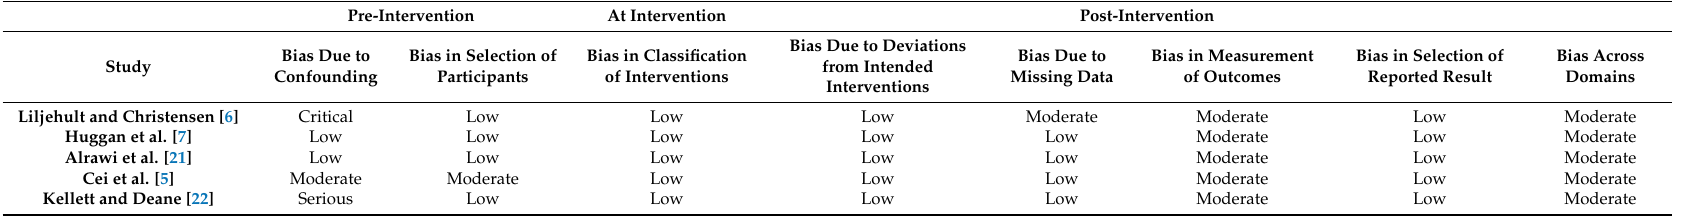
Table 1. Summary of quality assessment using the Risk of Bias in Non-Randomised Studies—of Interventions (ROBINS-I) tool. Pre-Intervention At Intervention Post-Intervention Bias Due to Deviations Bias Due to Bias in Selection of Bias in Classification Bias Due to Bias in Measurement Bias in Selection of Bias Across from Intended Confounding Participants of Interventions Missing Data of Outcomes Reported Result Interventions